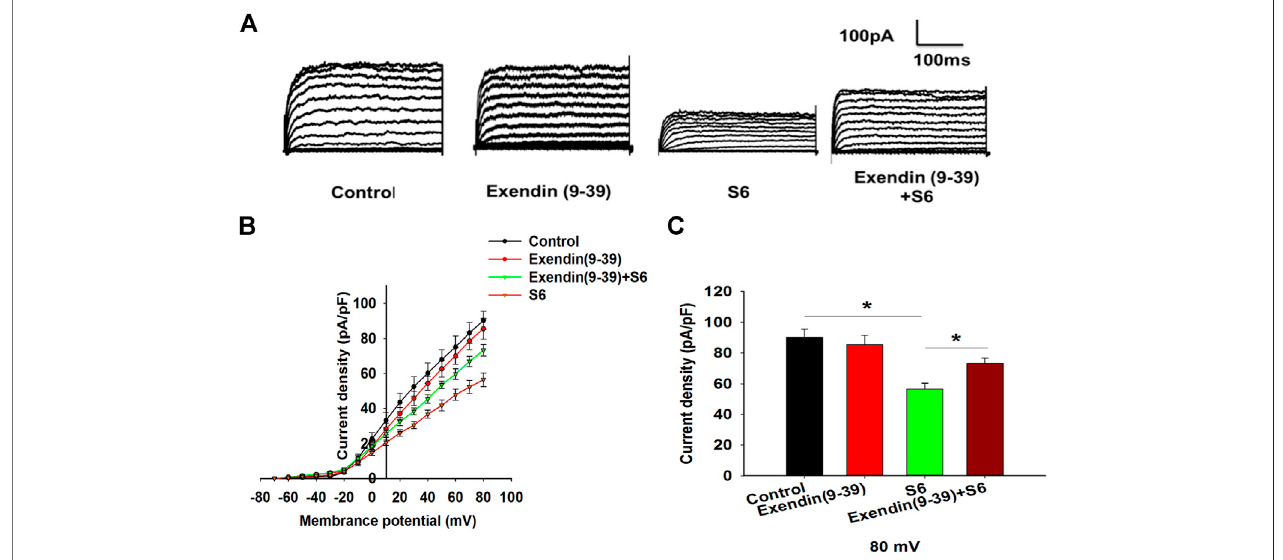
FIGURE 5 | S6 inhibits Kv channels via modulating GLP-1R. (A) Representative current traces recorded under the different interventions. (B) Current-voltage relationship curves of Kv channels. (C) Summary of the mean current density of Kv channels recorded at 80 mV depolarization. Data are expressed as the mean ± SEM and compared by one-way ANOVA. n (cid:2) 7, * p <